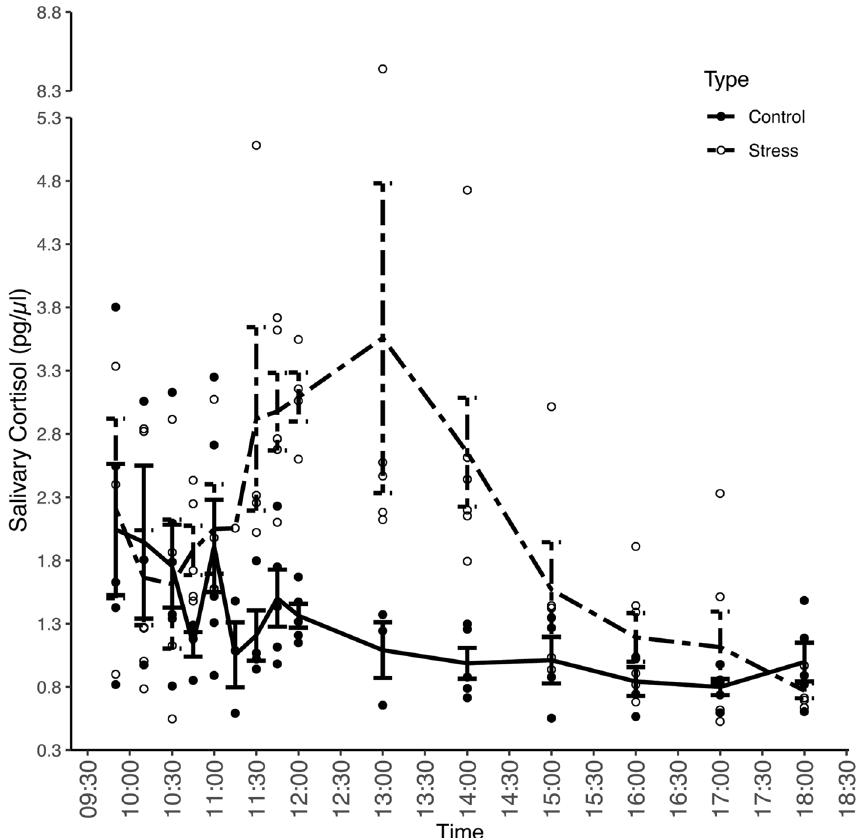
Figure 2. Mean (+ SEM) salivary (N = 136) cortisol levels in bonobos during the control day (solid line) and stress day (dashed line). The local veterinarian (the stressor) entered the building at 10:18 h. The analyses were conducted on log transformed cortisol data but actual values are displayed here to provide better visual and interpretable representation of the cortisol response.